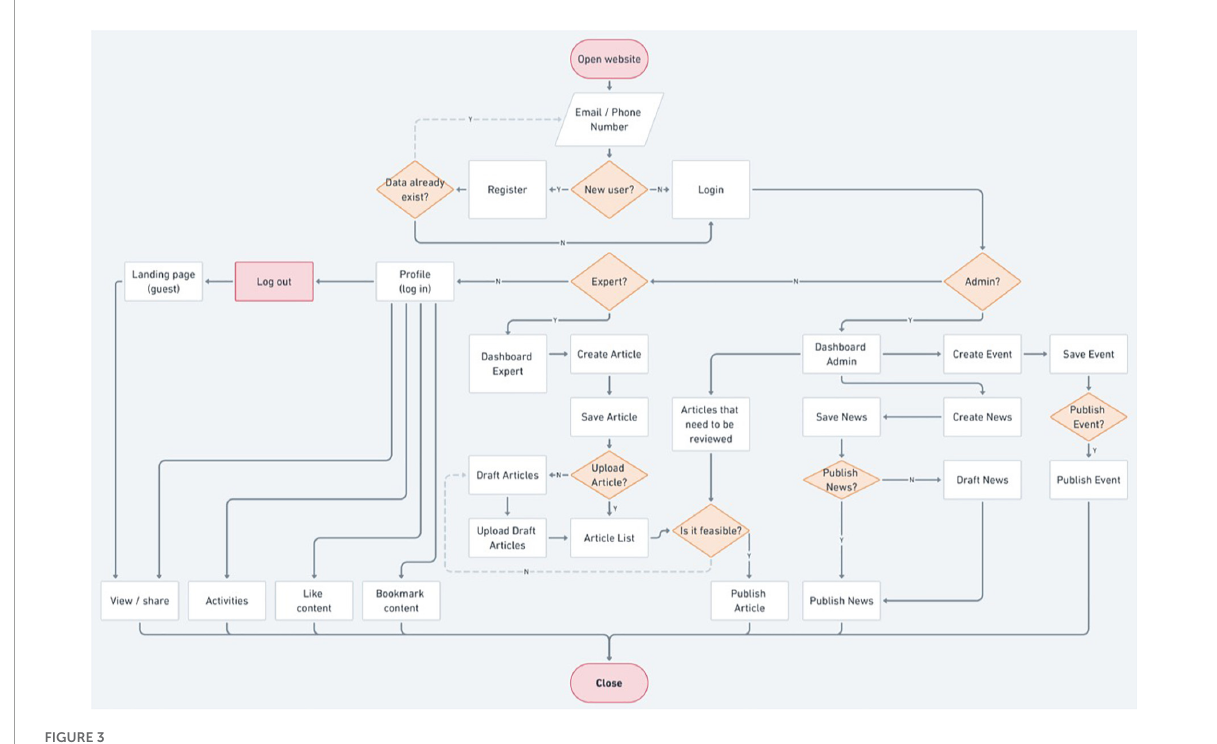
FIGURE3 Flow chart of user